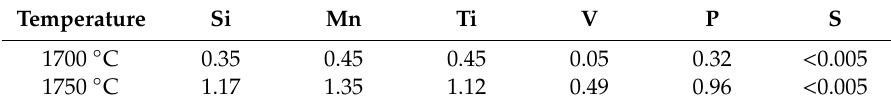
Figure 12. Mössbauer spectra of pig iron sample obtained at 296 K.